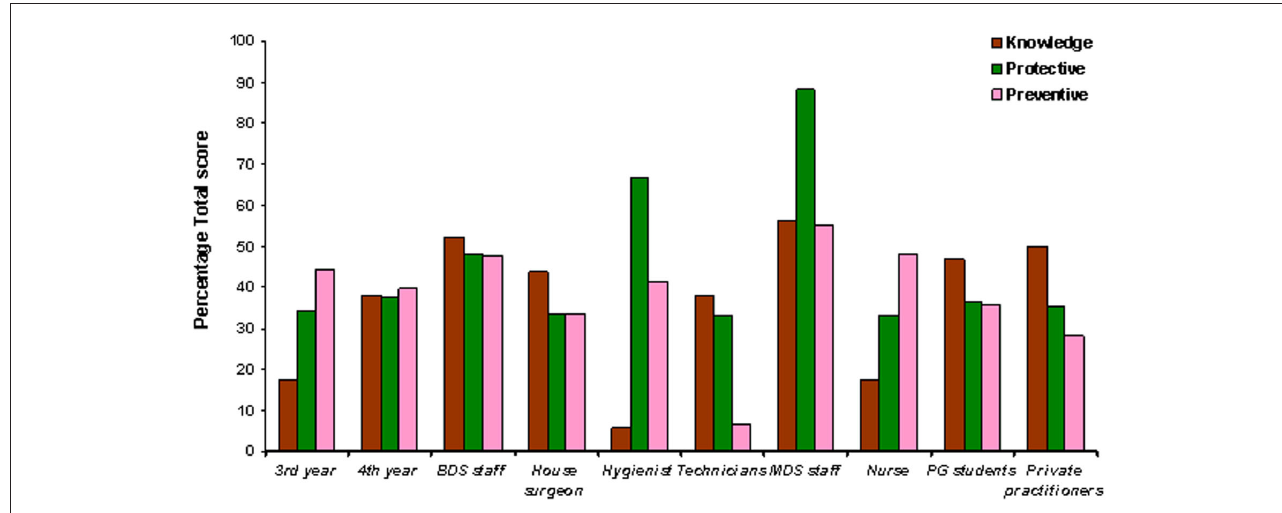
Fig. 1. knowledge, Protective and Preventive measures followed by